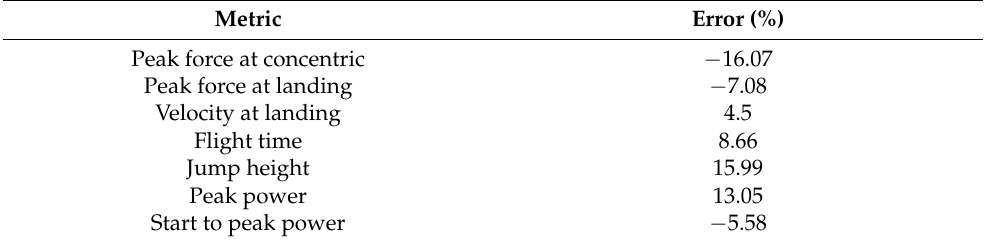
Table 3. Jumping-related metric